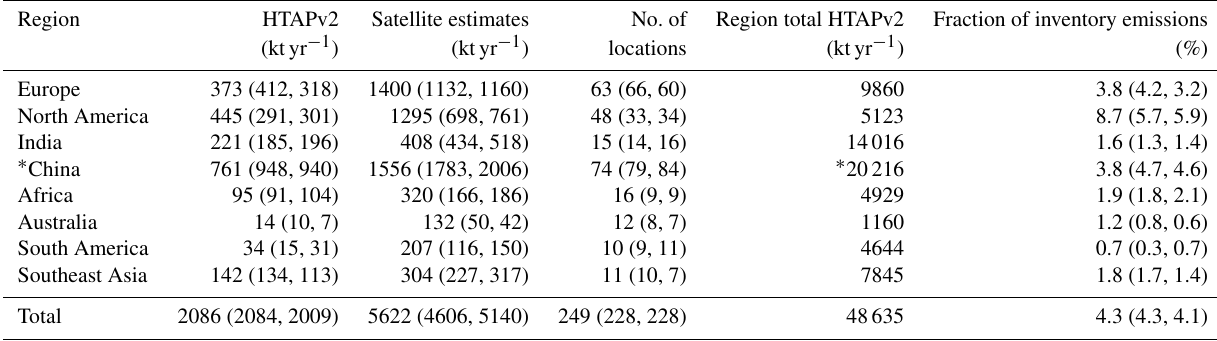
Table 4. Summary of the CrIS, IASI-A and IASI-B emission estimates per region vs. HTAPv2 inventory entries for all successful fits with a correlation > 0.3 and a SNR > 2. Each entry represents the CrIS value with the IASI-A and IASI-B values following between the brackets: CrIS (IASI-A,